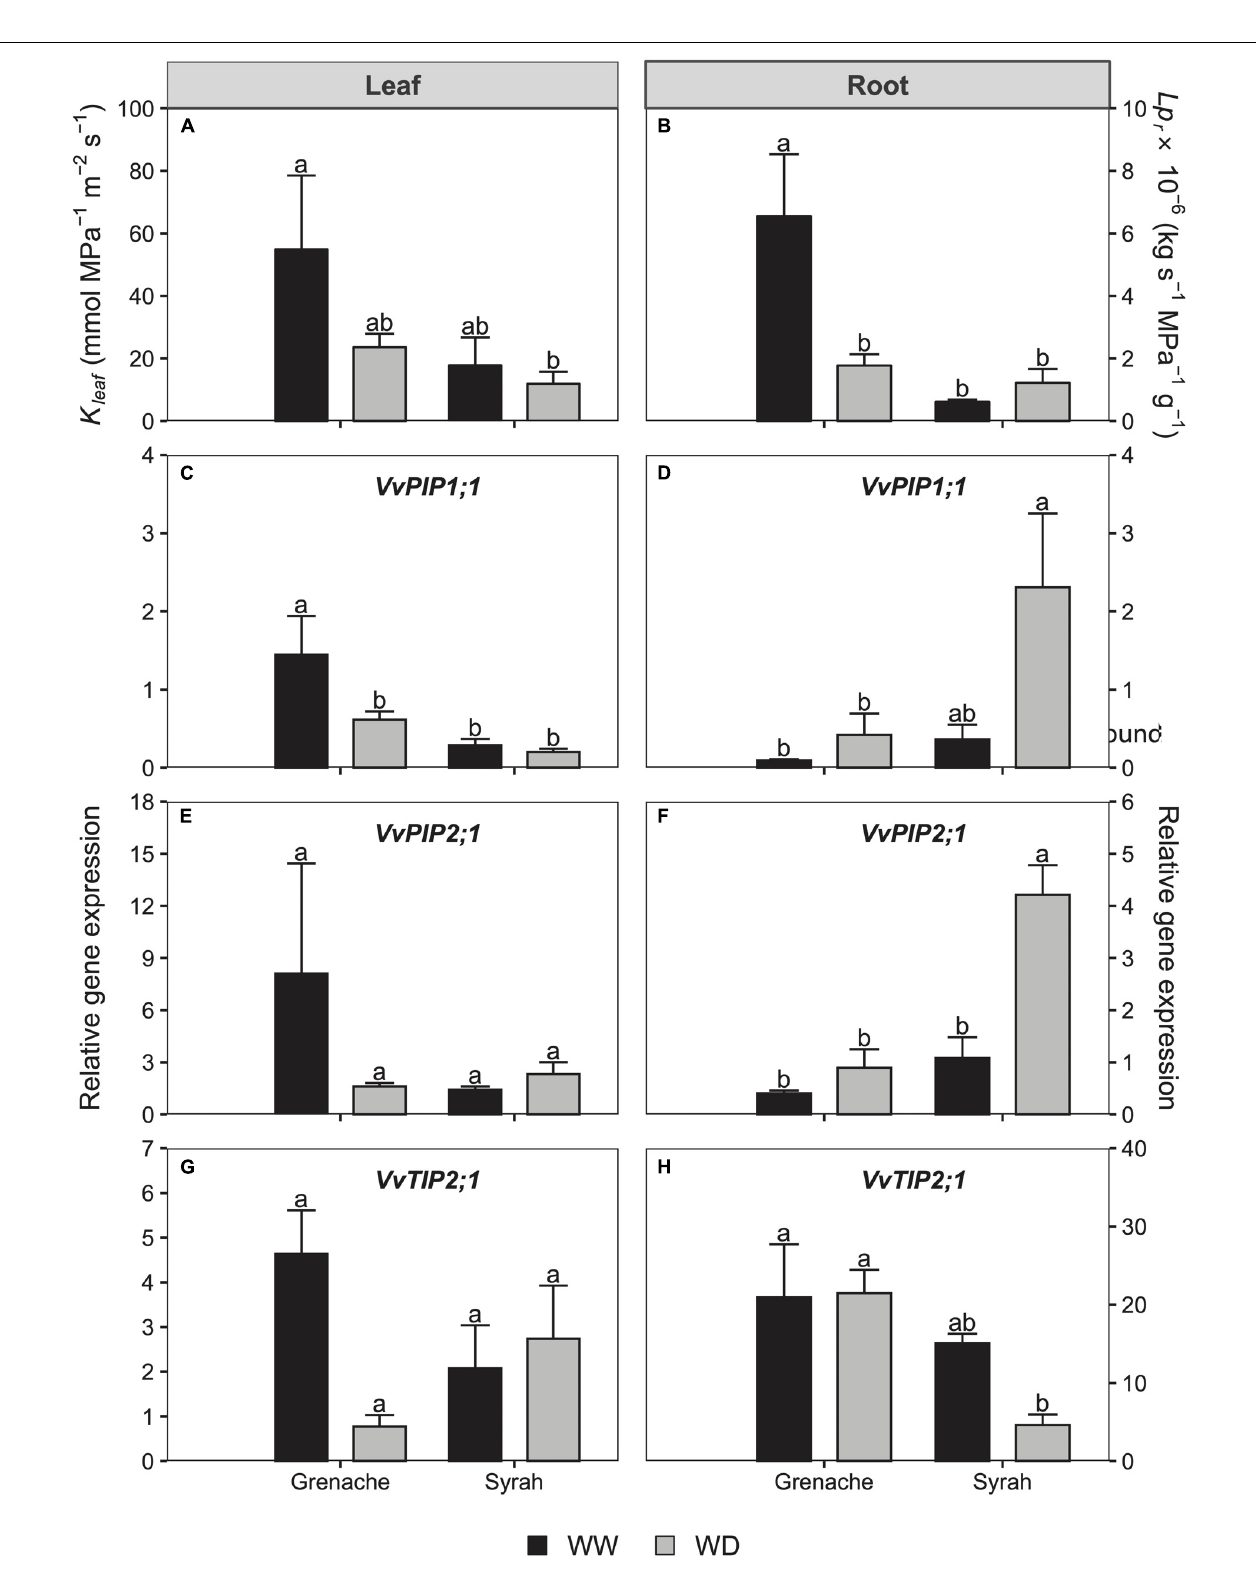
FIGURE 5 | Leaf ( K leaf ; A ) and root ( Lp r ; B ) hydraulic conductances and gene relative expression of PIP1 ; 1 , PIP2 ; 1, and TIP2 ; 1 in the leaf (C,E,G) and roots (D,F,H) in Grenache and Syrah grapevines under well-watered (WW) and mild water deficit (WD) at Day 5 of the experiment. Values are means ± SE ( n = 3). Different letters indicate statistically significant differences ( P ≤ 0.05) across both treatments and